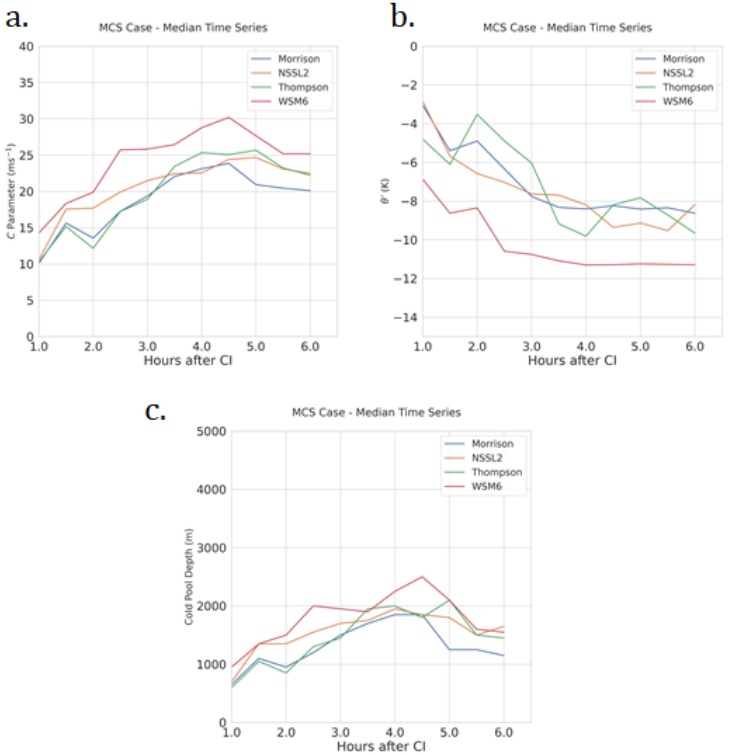
Figure 8. Median values of ( a ) cold pool parameter C, and ( b ) perturbation potential temperature ( θ ′ ), and ( c ) cold pool depth over time for the MCS case of 13 June 2016 simulated in the WRF.